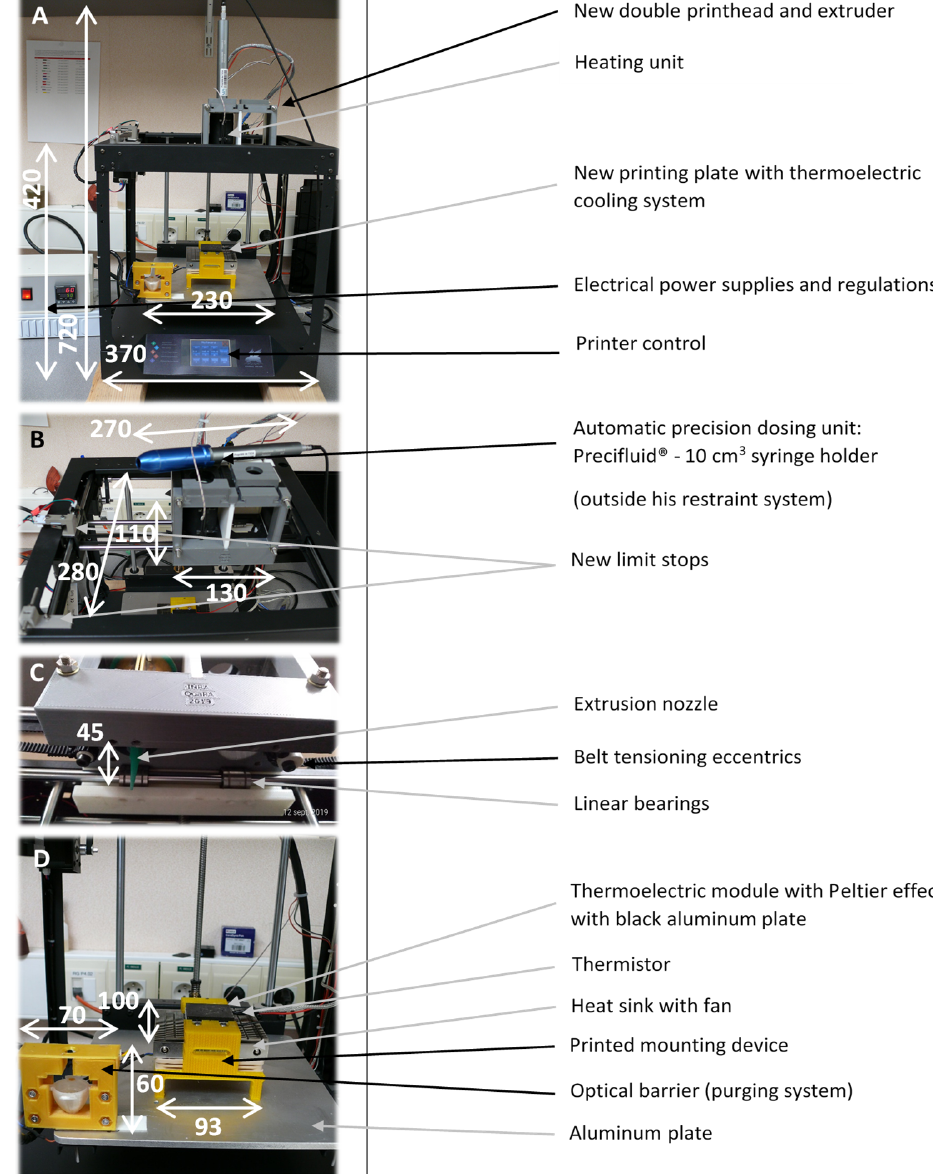
Figure 3. ( A ) General view of the lab-scale modified Ghost printer. ( B ) Top view of the printhead with the volumetric dosing system removed. ( C ) Bottom view of the printhead. ( D ) View of the new printing plate (usable area 16 cm 2 ). Dimensions are in mm. The drawings of the specifically-designed parts for modifying the 3D printer are available in Supplementary Materials S2. The original volume of the printhead was increased by a factor of four compared to the original head. The limit switches were therefore relocated and mounted on new 3D printed stainless steel supports. Linear guides were also added for x -axis movement (Figure